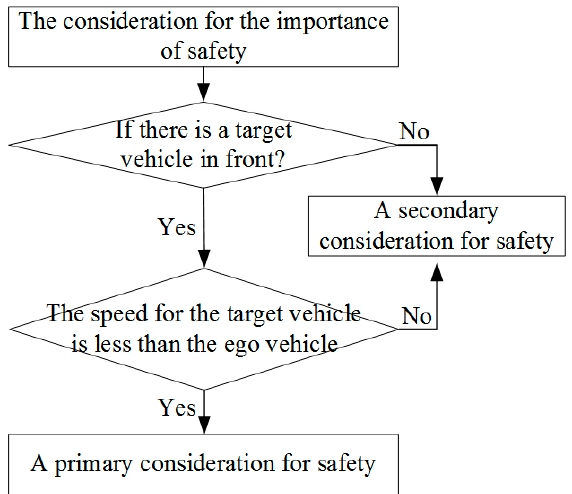
Figure 7. The consideration for the importance of driving safety indicators. According to the theory of the rigid body collision and vehicle kinematics, the rela- tive distance involved in the process of car-following can be divided based on the degree of danger, as shown in Figure 8. The green part ( D relative > d safe ) means that when the actual relative distance between two vehicles is larger than the safety distance, then the ego ve- hicle is in a safe state. The yellow part ( d emergency < D relative < d safe ) means that the actual relative distance between two vehicles is smaller than the safety distance, but if the ego vehicle brakes, then the collision will not happen. The red part ( D relative < d emergency ) means that the actual relative distance between two vehicles is smaller than the danger distance, and then the collision will happen. In the above process, the safety that we mainly considered is reflected in the yellow part—that is, the corresponding condition can be described as the target vehicle being stationary or braking suddenly.